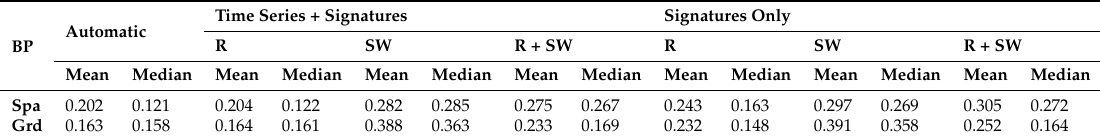
Table 3. Relative difference of Bilan model parameters Spa and Grd between expert calibration and other calibration strategies. Automatic, time series + signatures and signatures only mean calibration strategies which combinate runoff (R), soil moisture (SW) or runoff + soil moisture (R + SW).